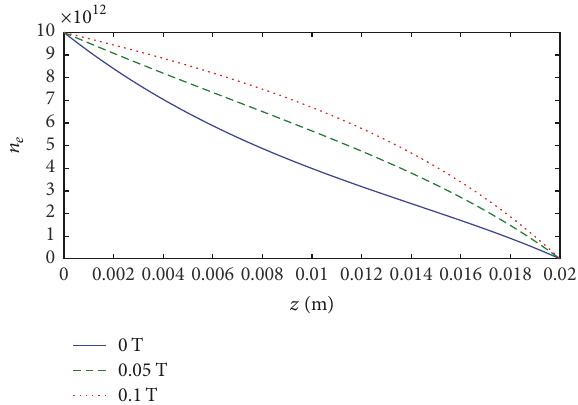
Figure 2: Axial electron density distribution under different magnetic fields.